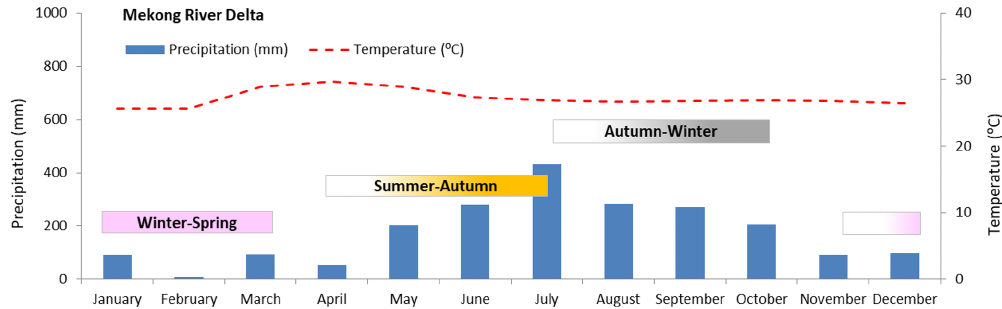
Figure 2. Climograph for the Mekong River Delta annotated with the winter–spring, summer–autumn and autumn–winter growing seasons. The color gradient (from faded to dark) represents planting, growing and harvesting times for each crop. Precipitation and temperature data were taken from the Statistical Yearbook of Vietnam 2018 (General Statistics Office,